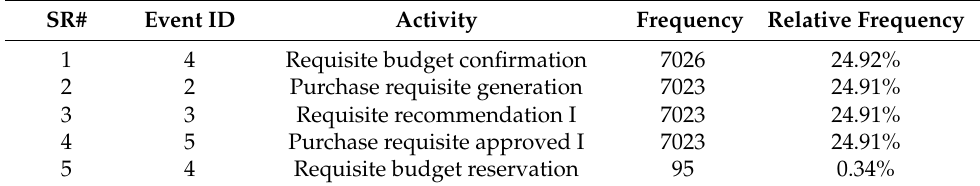
Table 10. Activity statistics of log data after removal of